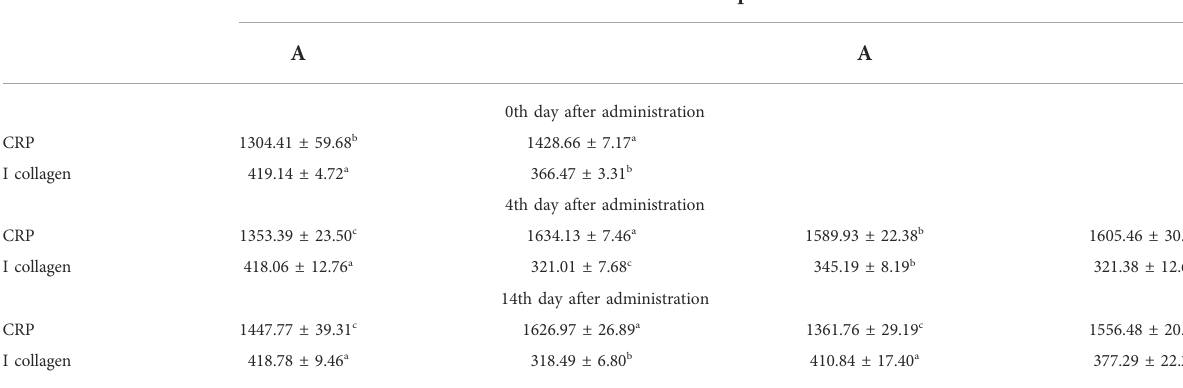
TABLE 3 CRP and I collagen results are presented as SD ± SE; statistically signi fi cant data are given as a,b,c,d p < 0.05.